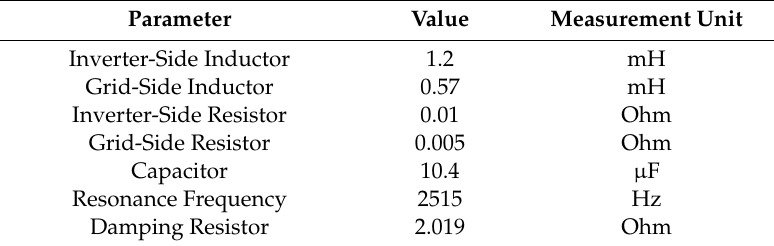
Table A6. Parameters of the LCL